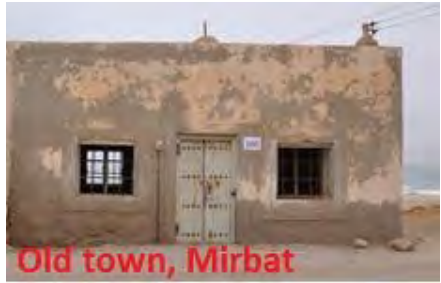
Figure 7. Fac¸ade’s photograph building location